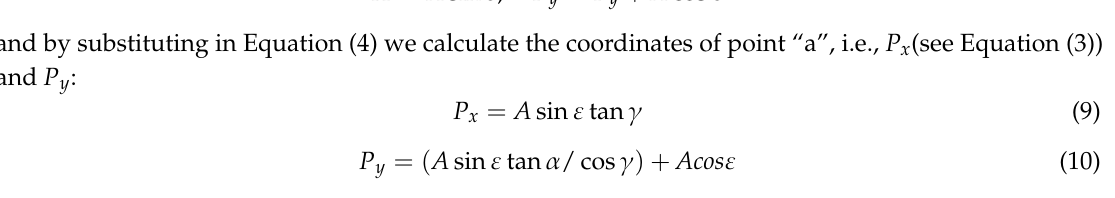
Figure 4. Horizontal plate attached perpendicular to a wall.